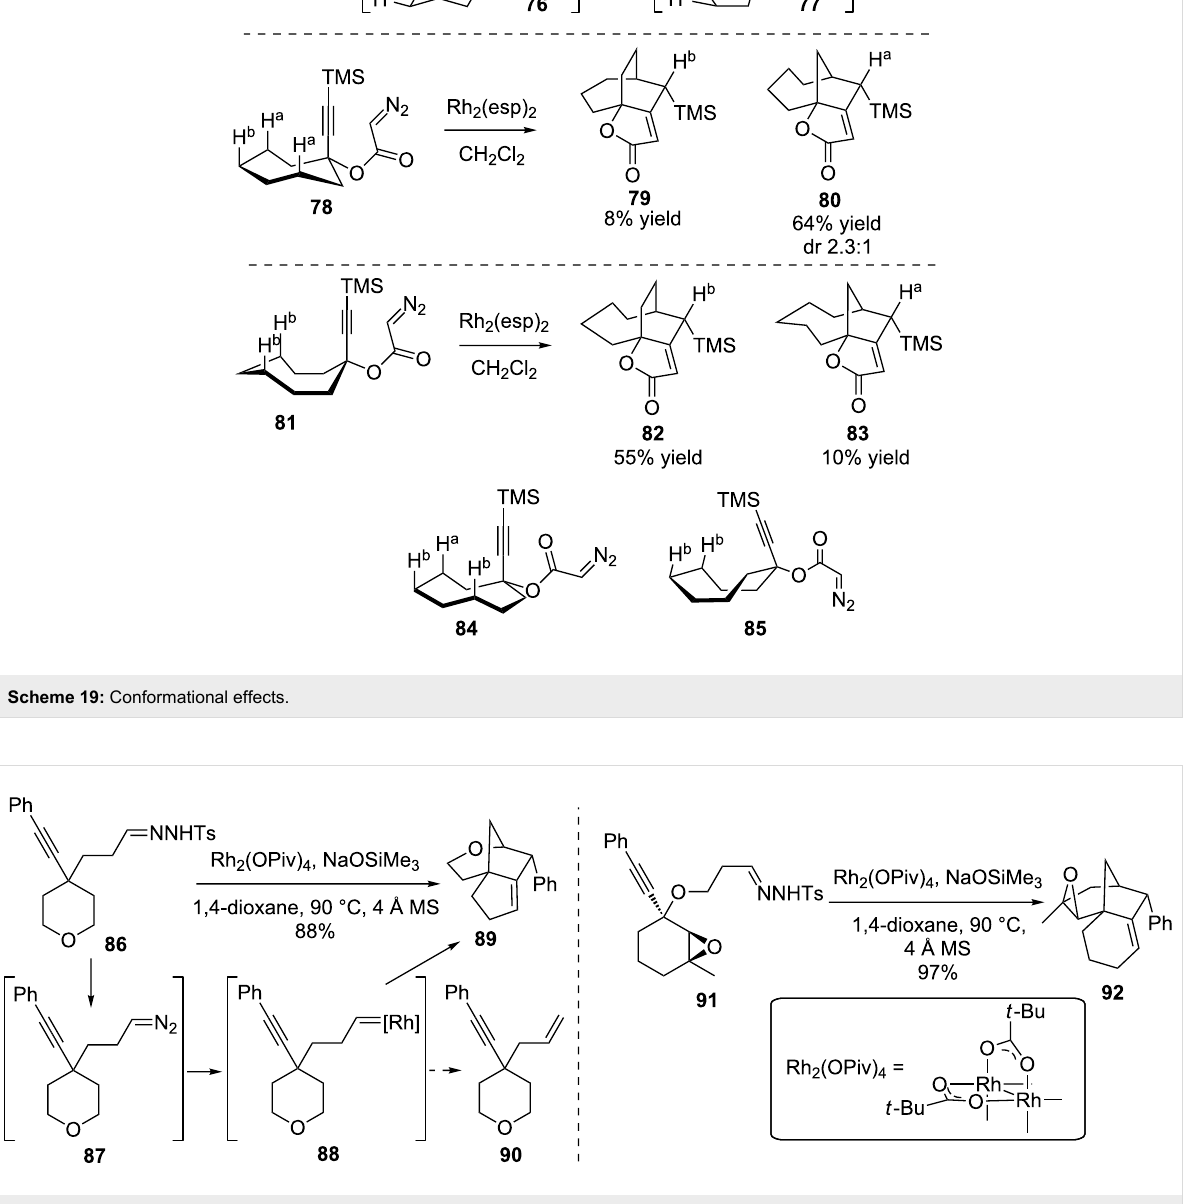
Scheme 20: Hydrazone cascade